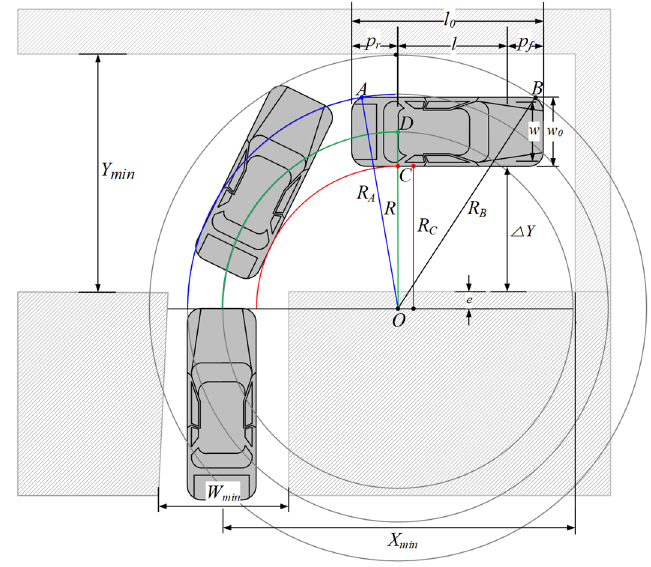
Figure 1. Three-characters ( 𝑆 (cid:2878) 𝑅 (cid:2879) 𝑆 (cid:2879) ) perpendicular parking.